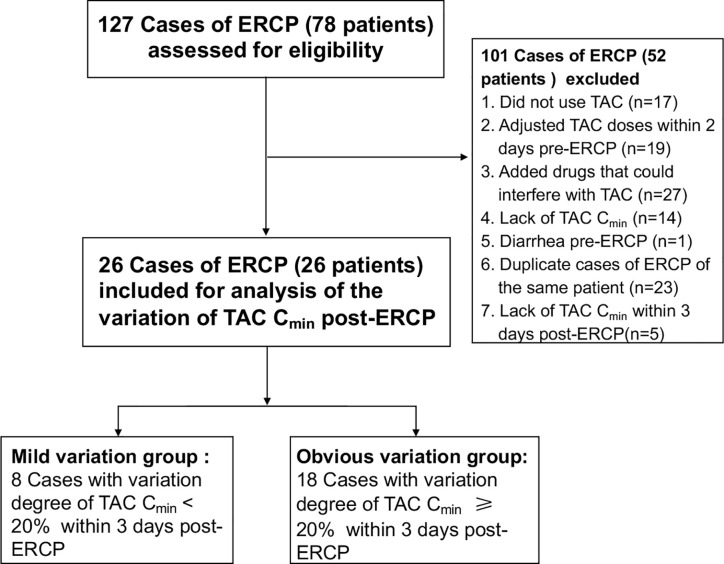
Study flow diagram.